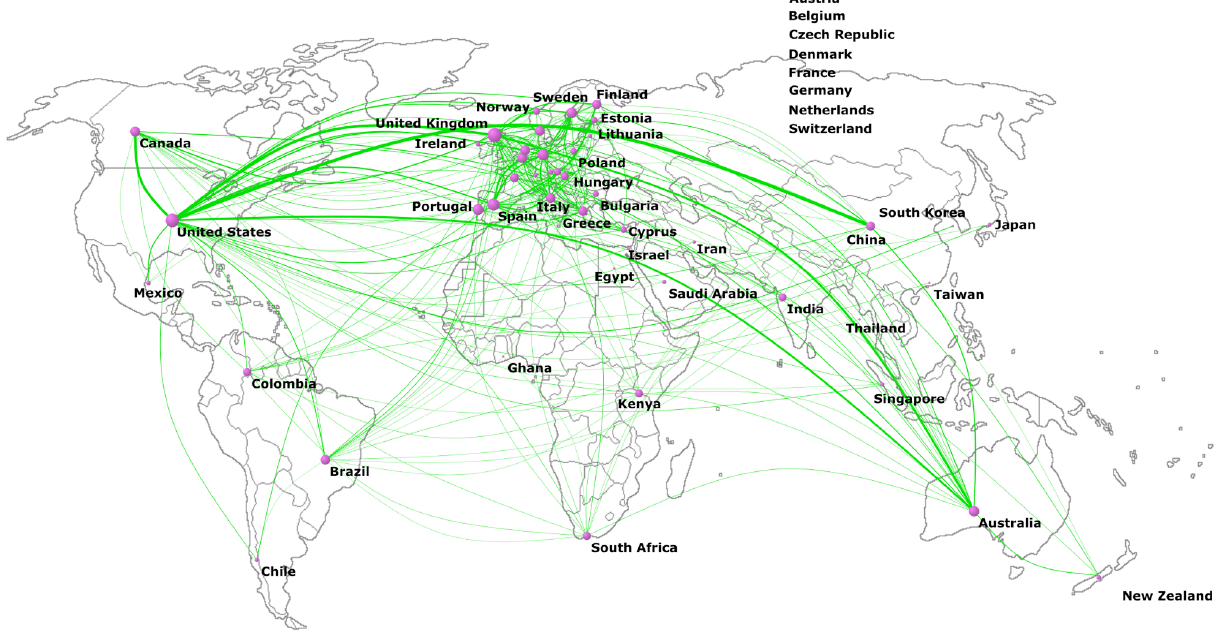
Figure 3. World map of collaboration between